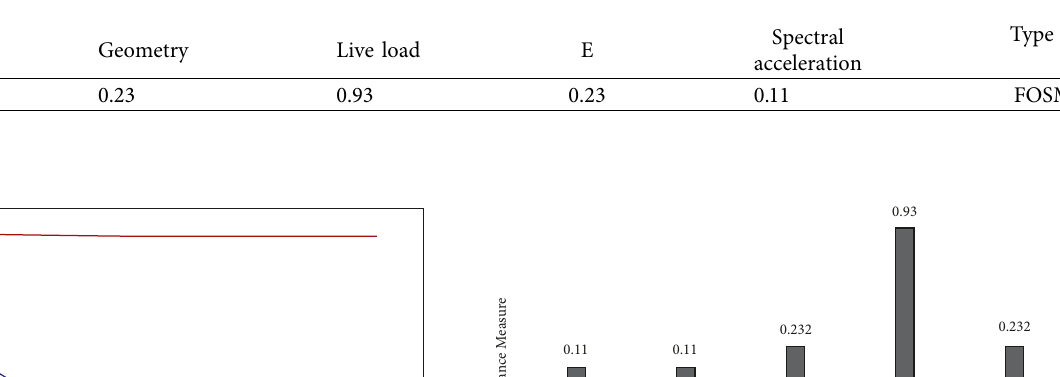
Table 5: Results of the significance of uncertainties scale in FOSM analysis of type II headed frames. Uncertainty